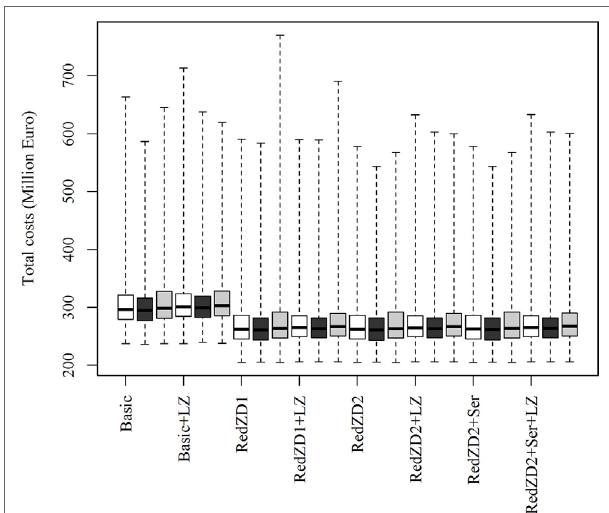
FigUre 3 | Box plots of the predicted total costs of African swine fever-epidemics using different control scenarios with changed values for the transmission rate of the virus. The empty, black and gray boxes represent the control scenario with the default, reduced and increased transmission rate value, respectively. Basic: (1) culling, cleaning, and disinfection of affected herds; (2) 3-day national standstill on animal movements; (3) 3-km protection zone—duration 50 days + 10-km surveillance zone duration 45 days (movements and contact restrictions in zones); and (4) tracing of movements and contacts. Basic + LZ: basic control + surveillance zone 15 km (default: 10 km). Red.ZD1: Basic + duration of protection and surveillance zones 35 days (default: 50 and 45 days). Red.ZD1 + LZ: Red.ZD1 + surveillance zone 15 km (default: 10 km). Red.ZD2: Basic + duration of protection and surveillance zones 35 and 25 days, respectively (default: 50 and 45 days). Red.ZD2 + LZ: Red.ZD2 + surveillance zone 15 km (default 10 km). Red. ZD2 + Ser: Red.ZD2 + serological testing in surveillance zone before lifting the zone (default: clinical surveillance). Red.ZD2 + Ser + LZ: Red. ZD2 + Ser + surveillance zone 15 km (default:10